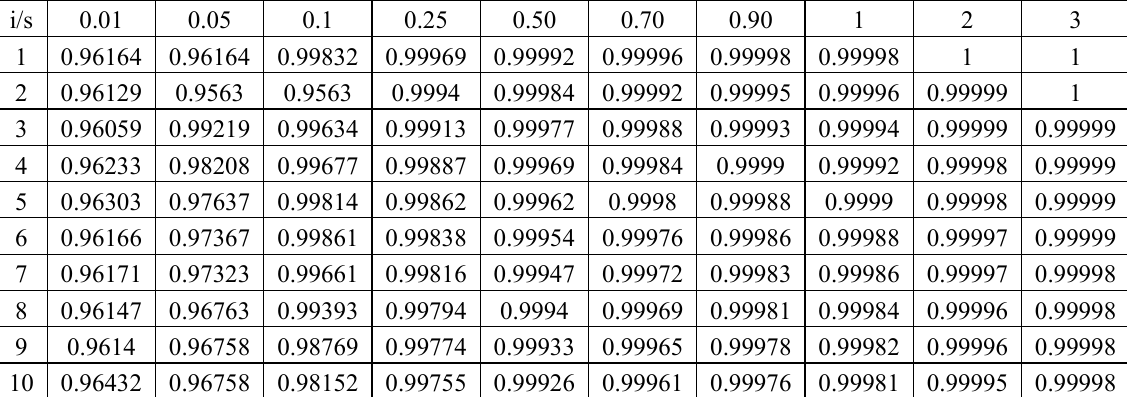
Table 4. RBFNN topology regression performance (i = nodes in the input layer, s = spread factor). i/s